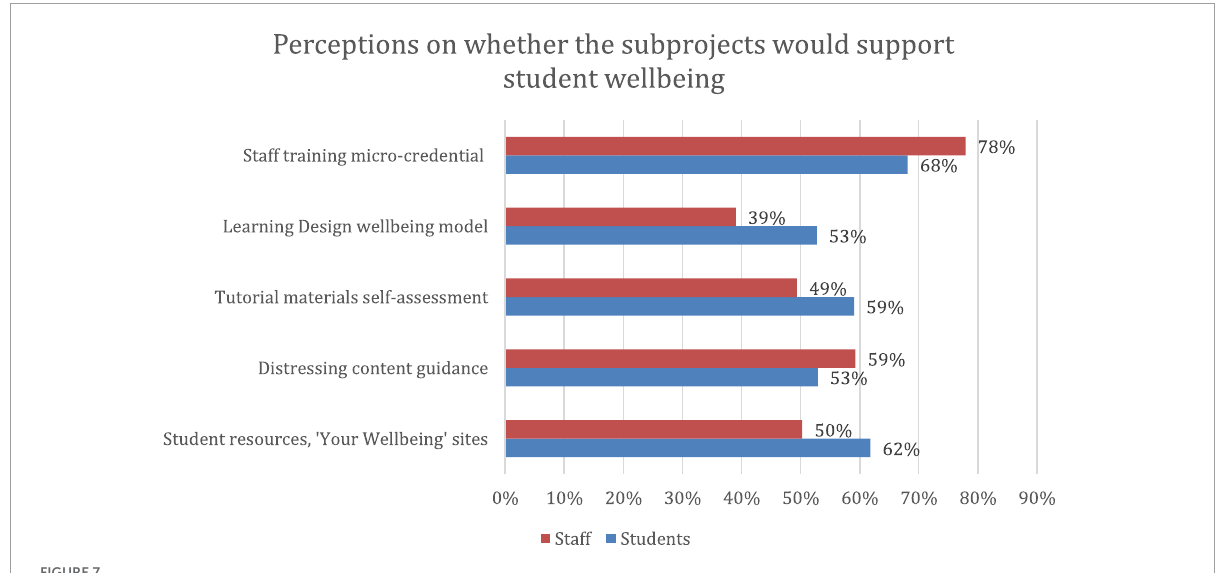
FIGURE7 Open University staff and student survey responses on whether subprojects would help wellbeing.